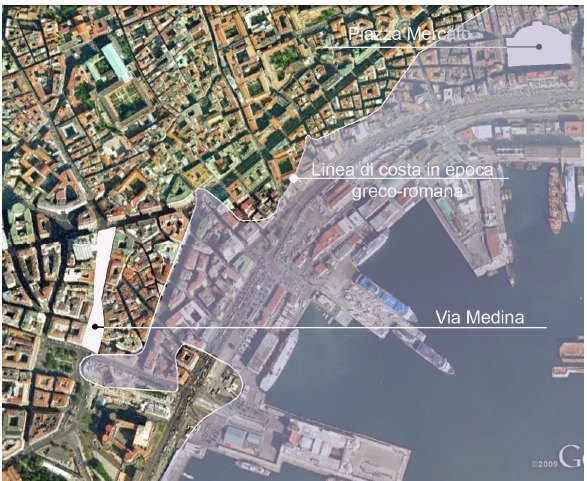
Figure 12: to correctly set up the communication project is very important using a recognizable image. Communication is effective if you always use the same points of reference: the castle, piazza Mercato, Medina